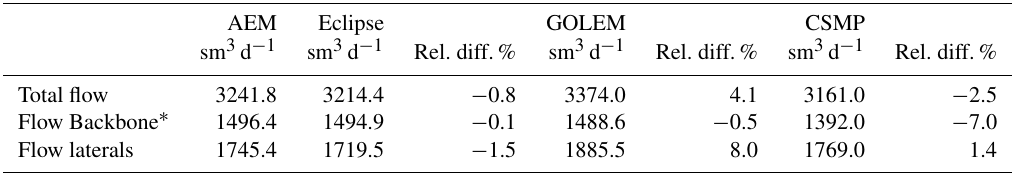
Table 1. Settings with fault properties for two fault scenarios. Medium Dimension Porosity Storage Permeability k XY Permeability k Z Aperture a Transmissivity T [−] [ 1 / Pa ] [ m 2 ] [ m 2 ] [ m ] [ m 3 ] Scen. 1 2-D 1 4 × 10 − 10 2.027 × 10 − 8 2.027 × 10 − 8 Scen. 2 2-D 1 Table 2. Total flow and relative difference with the results of AEM for all simulators for case 1: vertical well with four laterals. AEM Eclipse GOLEM CSMP sm 3 d − 1 sm 3 d − 1 Rel. diff.% sm 3 d − 1 Rel. diff.% sm 3 d − 1 Rel. diff.% Total flow 3241.8 3214.4 − 0.8 3374.0 4.1 3161.0 − 2.5 Flow Backbone ∗ 1496.4 1494.9 − 0.1 1488.6 1392.0 Flow laterals 1745.4